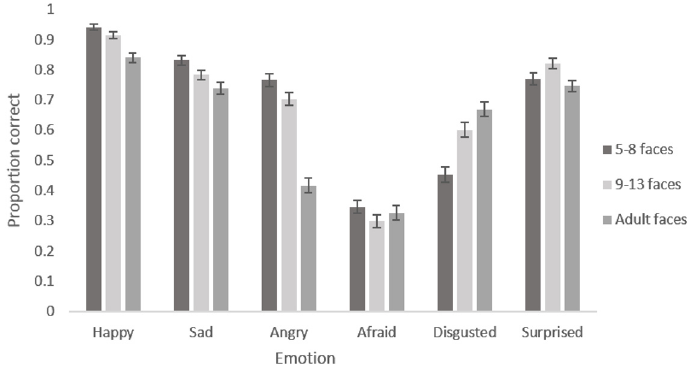
Fig 3. Mean proportion of correct responses to images showing each emotion from each age face set. Error bars show standard error.